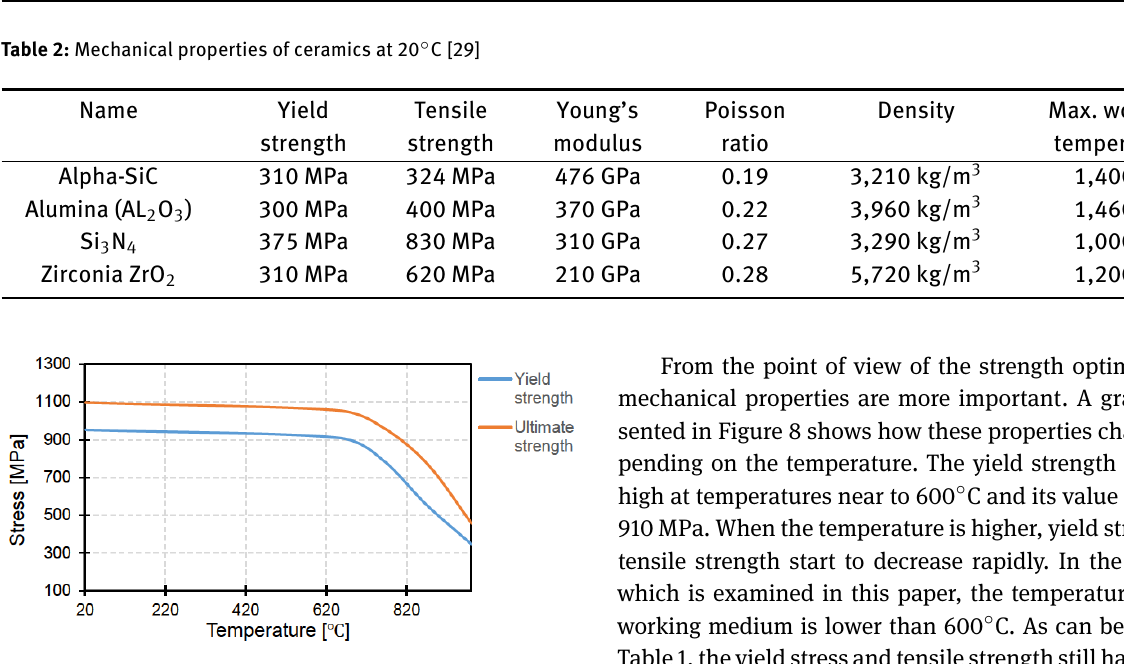
Figure 8: Dependency between yield strength, ultimate strength and temperature for Inconel